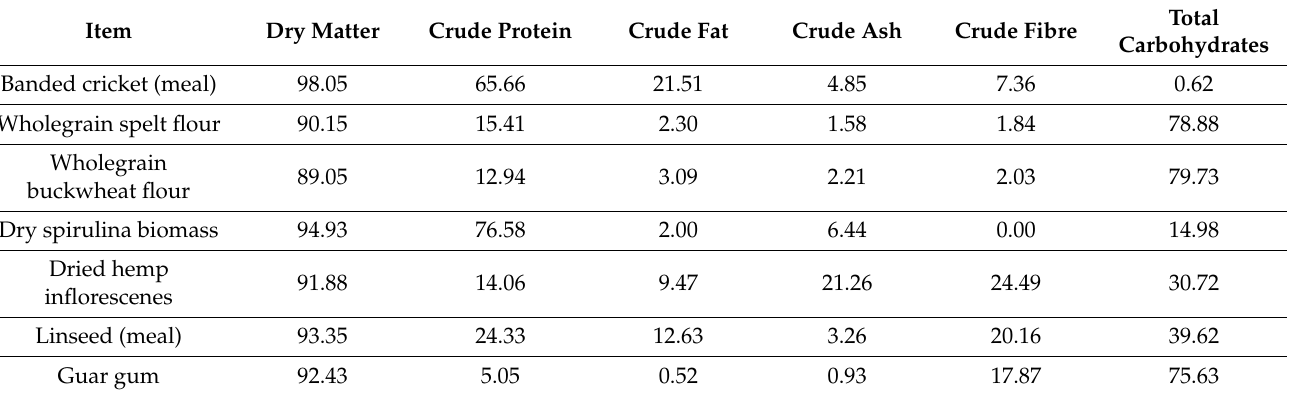
Table 1. Proximate composition of ingredients (g/100 g) used in the production of